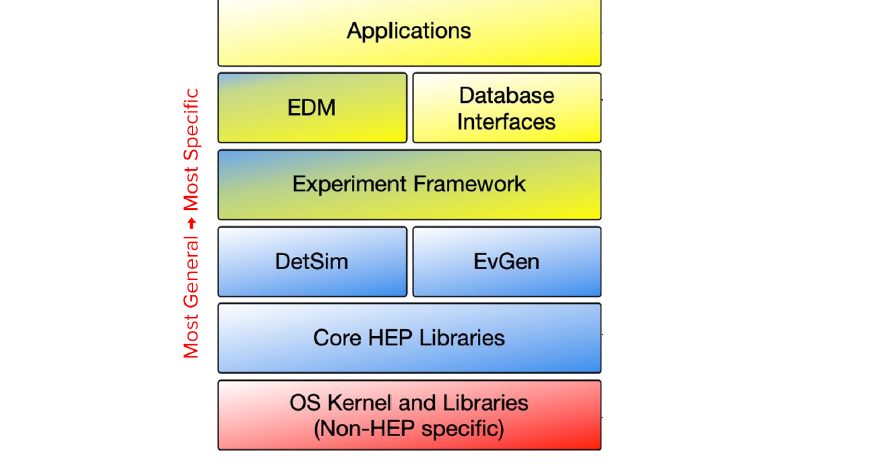
Figure 1. Illustrative figure showing a typical HEP software stack, with packages categorised from most general (bottom) to most specific (top). The lowest level components are generic to all systems, moving to scientific libraries, to common HEP packages to, finally, experiment specific